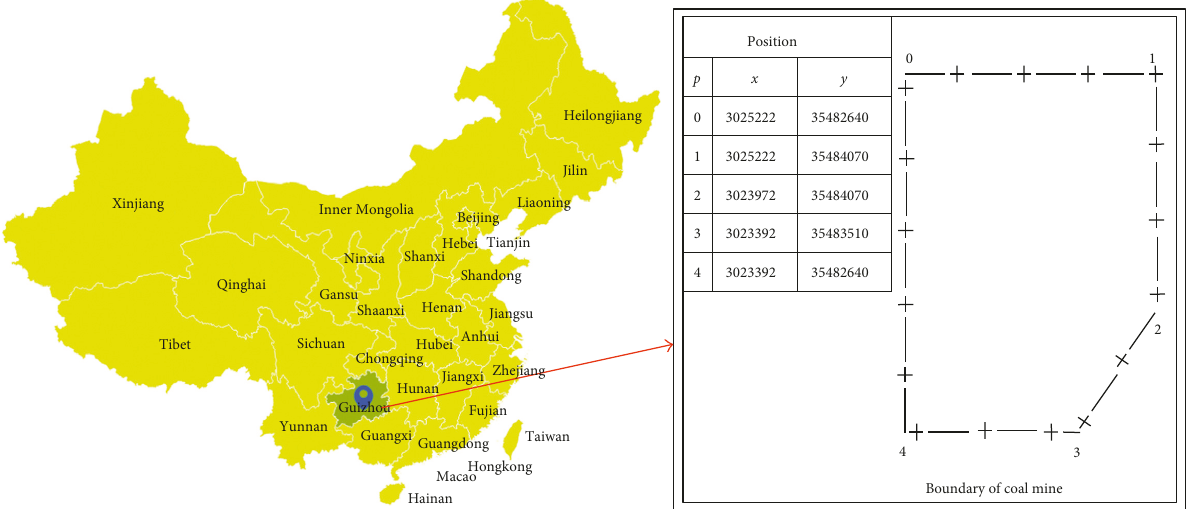
Figure 4: Location of test size.